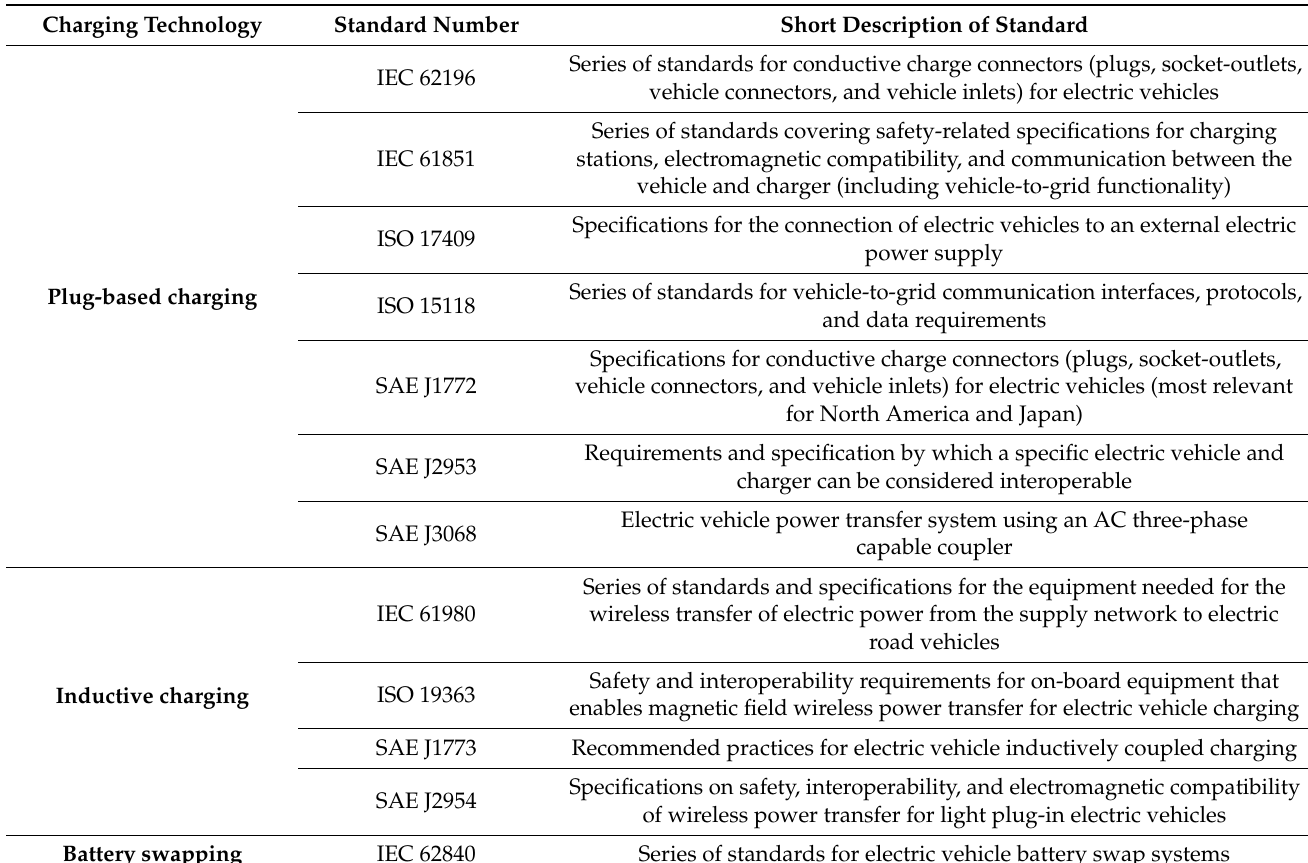
Table 2. Main international charging standards for plug-based charging, inductive charging, and battery swapping for EVs (Table 6—ITF (2020) “Regulations and Standards for Clean Trucks and Buses: On the Right Track?”, International Transport Forum Policy Papers, No. 77, OECD Publishing, Paris